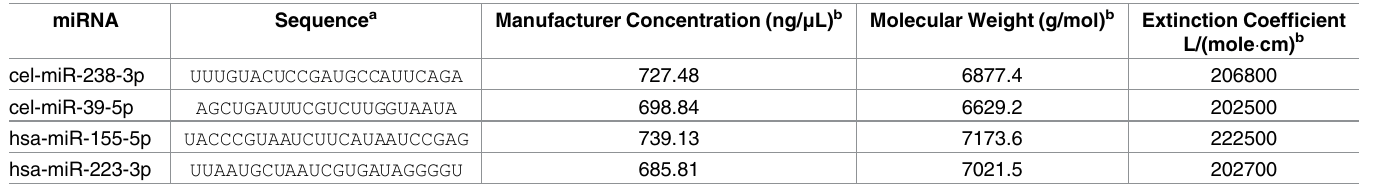
Table 1. General information about purchased synthetic oligonucleotides.